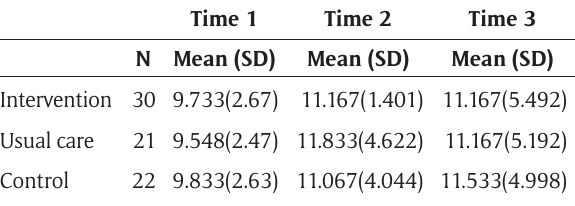
Table 4: Comparison of mean and standard deviation (SD) Readiness to Change Eating Habits scores between groups and across time points.